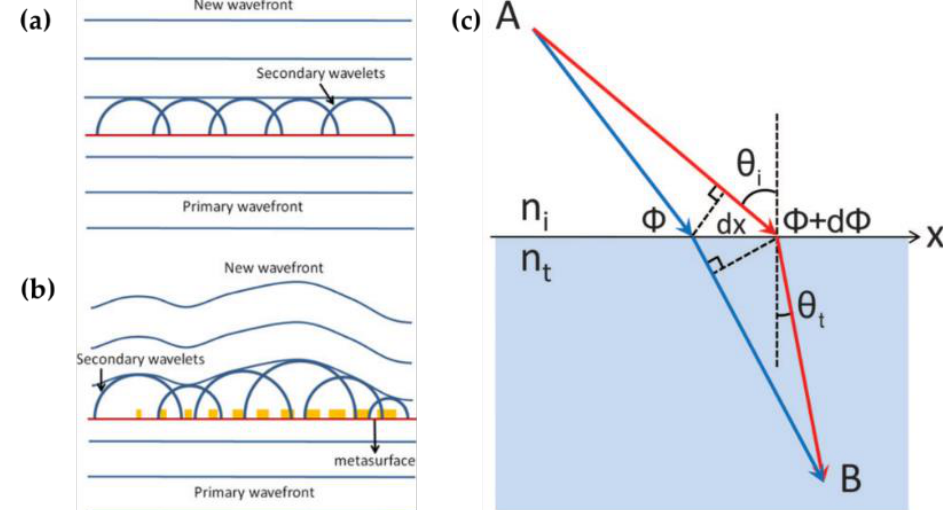
Figure 1. Schematics showing the Huygens’s principle with optical wavefront impinging on ( a ) nonstructured surface, and ( b ) a metasurface. Reprinted with permission from Ref. [23]. Copyright 2015 IEEE Photonics Society. ( c ) Schematic of derived generalized Snell’s law of refraction. Reprinted with permission from Ref. [13]. Copyright 2011 American Association for the Advancement of Science.